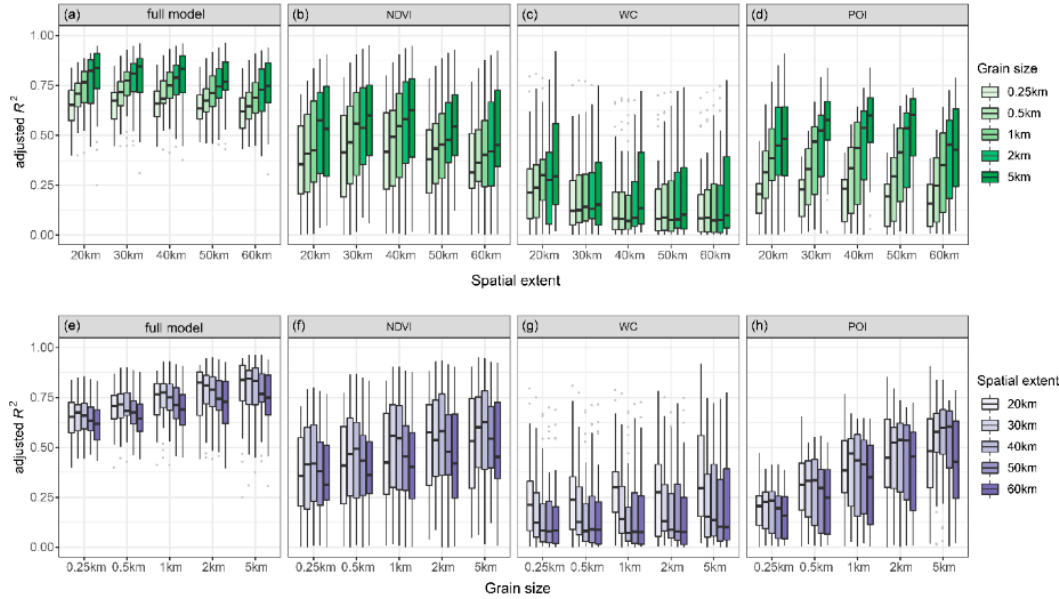
Figure 3. The power (adjusted R 2 ) of NDVI, water cover (WC), and POI density explaining the LST patterns across the grain size range from 0.25 km to 5 km (at each fixed spatial extent, a – d ) and the spatial extent range from 20 to 60 km (at each fixed grain size, e – h ).